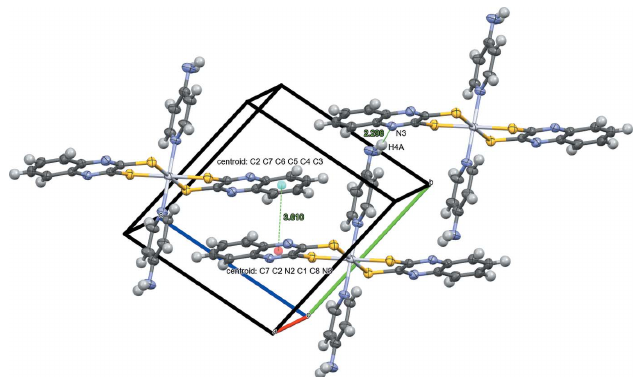
Figure 2 The packing of the complexes showing the hydrogen bonding between the H4 A amine hydrogen atom and the N3 ( x , y + 1, z ) atom on a neighboring qdt ligand as well as the sandwich orientation between adjacent qdt ligands and the distance (A˚ ) between centroids of two qdt rings. Displacement ellipsoids are drawn at the 50% probability level; the dmso solvate is omitted for clarity.